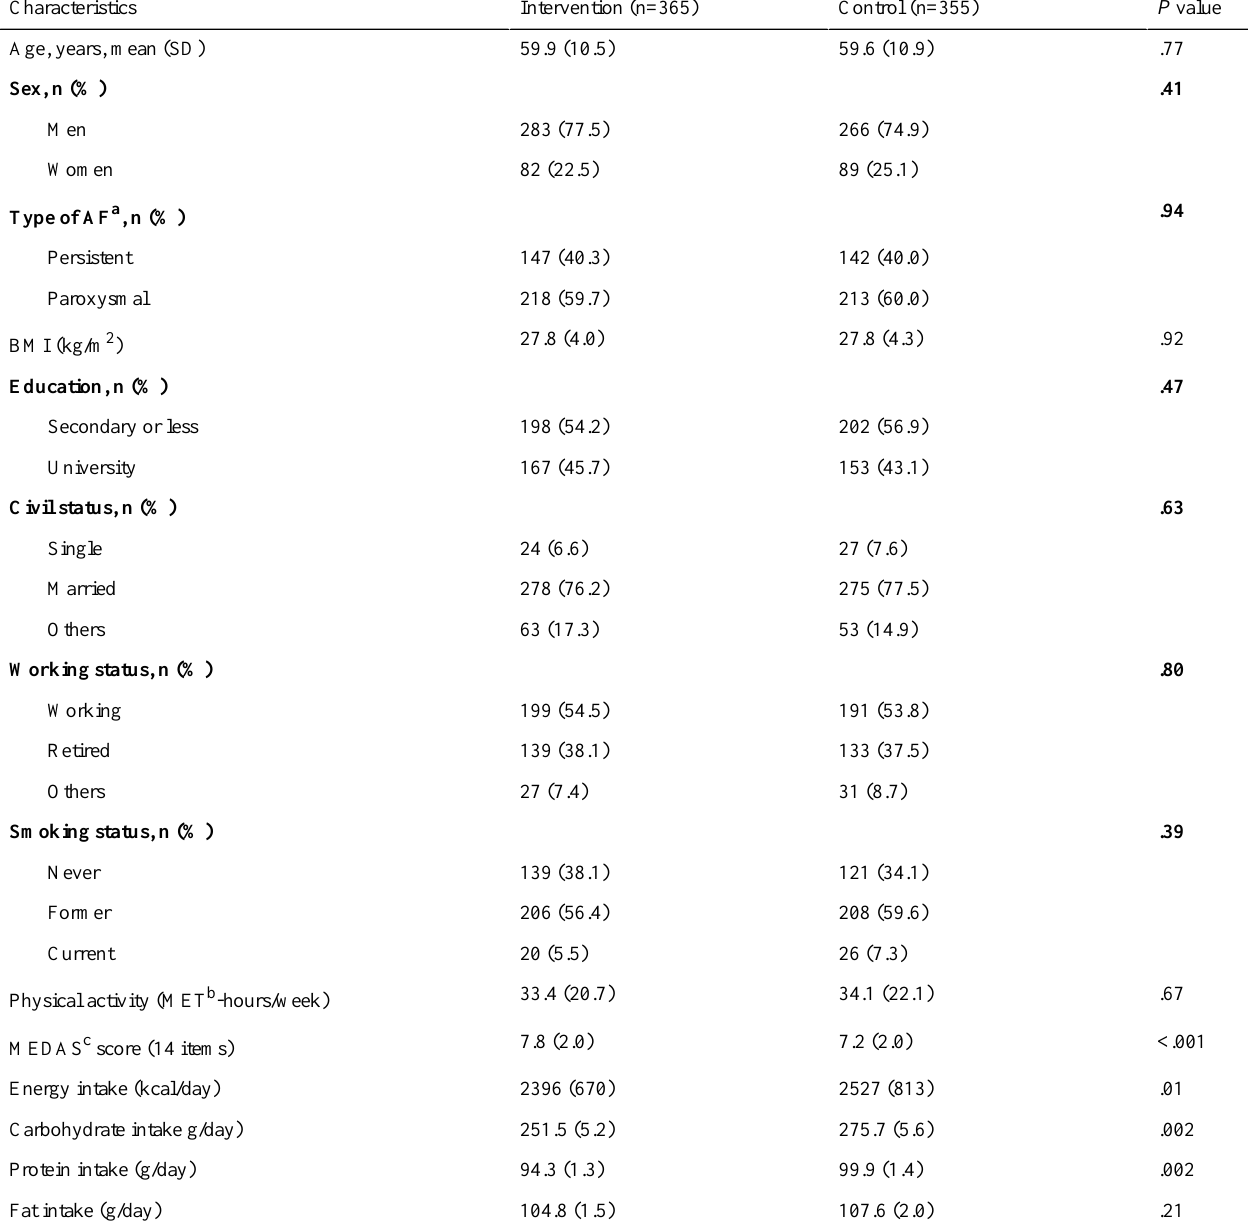
P valueControl (n=355)Intervention